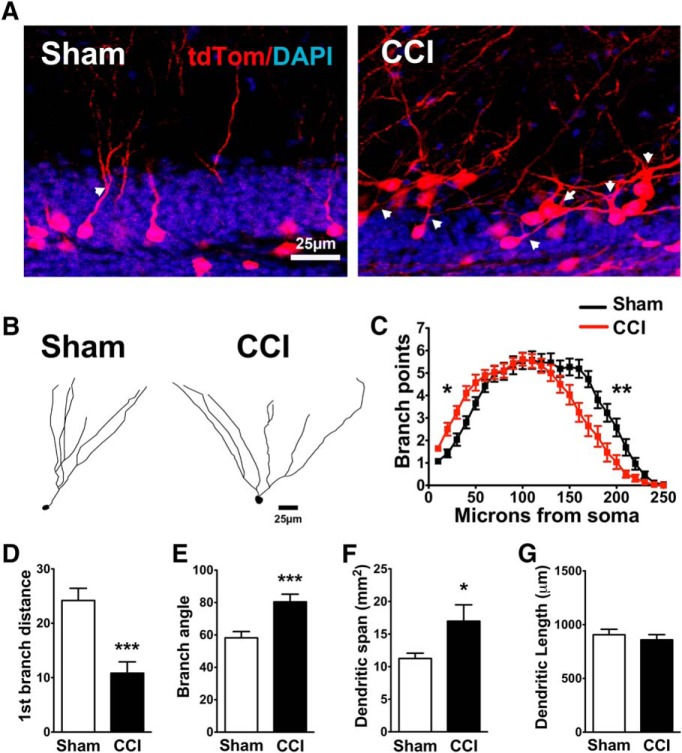
CCI-induced changes in the dendritic morphology of newborn neurons persist as these cells mature. A, Representative images of 4-week-old tdTom+ cells from sham and CCI-treated mice. Arrows point to the first dendritic branch point of selected cells. B, Representative tracings of tdTom+ cells from sham and CCI-treated mice. C, Sholl analyses of dendritic arborization of tdTom+ cells reveal a CCI-induced persistent increase in the number of branch points observed near the soma (*p = 0.0001, 0.003, 0.004, 0.003, and 0.049 for each 10 μm increment between 10 and 50 μm from the soma34), but a reduction in more distal regions (**p = 0.038, 0.002, 0.001, 0.009, 0.003, 0.003, 0.004, and 0.038 for each 10 μm increment between 150 and 220 μm from the soma34; n = 26 cells from 7 sham mice; 28 cells from 8 CCI-treated mice). D–F, tdTom+ cells from CCI-treated mice branched closer to their cell body (***p = 0.000135; D), and had wider angles (***p = 0.000736; E) and area (*p = 0.04037; F) between the dendrites that were farthest apart. G, tdTom+ cells from sham and CCI-treated mice had similar cumulative dendritic lengths (p = 0.5056).